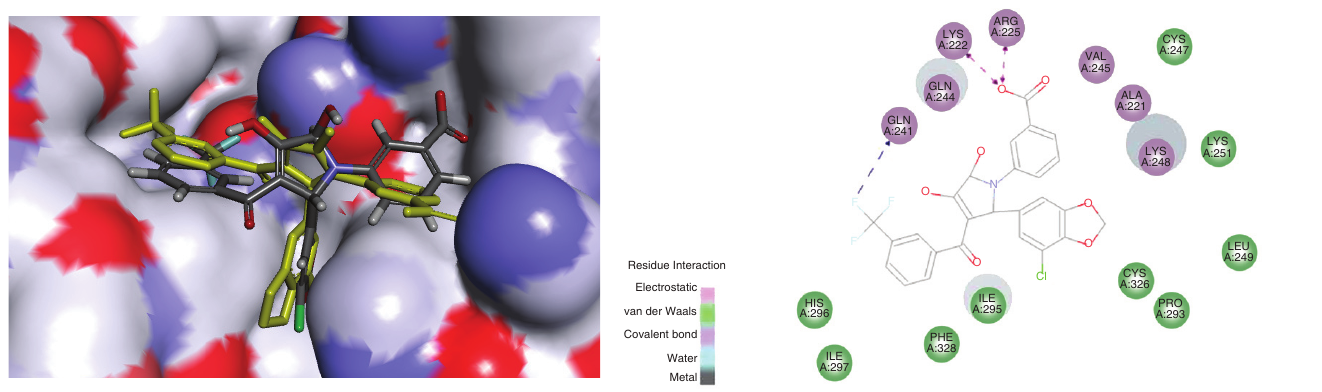
Supplemental Table 2. FDA drugs and common features pharmacophore. The dataset of 2643 molecules was downloaded from the CDD Public Access (https://www.collaborativedrug.com/pages/public_access) as an sdf and then a 3D database was created in Discovery Studio using FAST conformer generation with up to 255 conformations. The database was searched with the common feature pharmacophore developed from amodiaquine, chloroquine, clomiphene and toremifene. The search 3D database protocol was used with the Fast search method. In some cases the indication for the molecules is not described (ND). Supplemental Table 3. Microsource Spectrum and common features pharmacophore. The dataset of 2311 molecules was provided by Microsource (http://www.msdiscovery.com/spectrum.html) as an sdf and then a 3D database was created in Discovery Studio using FAST conformer generation with up to 255 conformations. The database was searched with the common feature pharmacophore developed from amodiaquine, chloroquine, clomiphene and toremifene. The search 3D database protocol was used with the Fast search method.